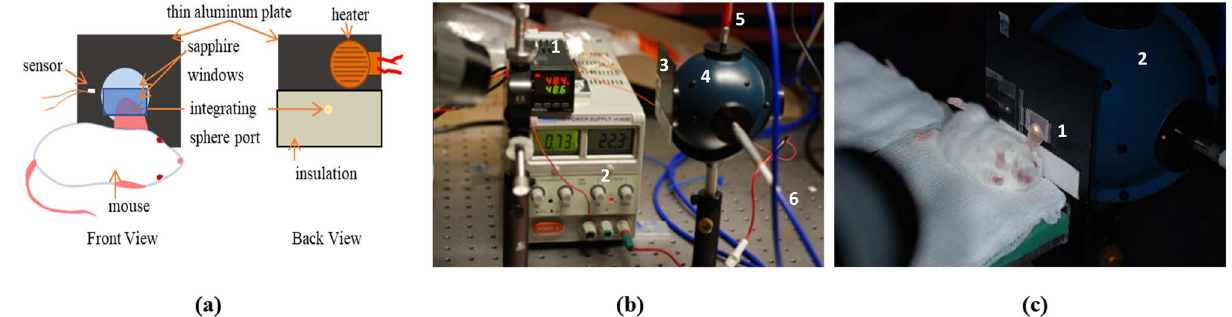
Figure 4. Lay-out of the integrating sphere experiments. ( a ) Diagram of the heating apparatus that was used to heat and maintain the desired tissue temperature while spectroscopic measurements were performed. Insulation between the aluminum plate and the integrating sphere, as well as between the aluminum plate and the mouse body prevented unnecessary heating. ( b ) Picture of integrating sphere system with heating apparatus. Temperature controller (1) was attached to a power supply (2) and aluminum plate (3). Controller (1) triggered external power for heating or cooling. Aluminum plate was attached to the sample port of the integrating sphere (4). Light collected by the integrating sphere passed through two optical fibers (5 and 6) coupled to the visible and NIR spectrometers. ( c ) Picture of total transmittance data acquisition. The mouse ear, sandwiched between two sapphire windows attached to the aluminum plate (1), was heated by the heater and the temperature was controlled by the temperature controller. Light transmitted through the ear was collected by the integrating sphere